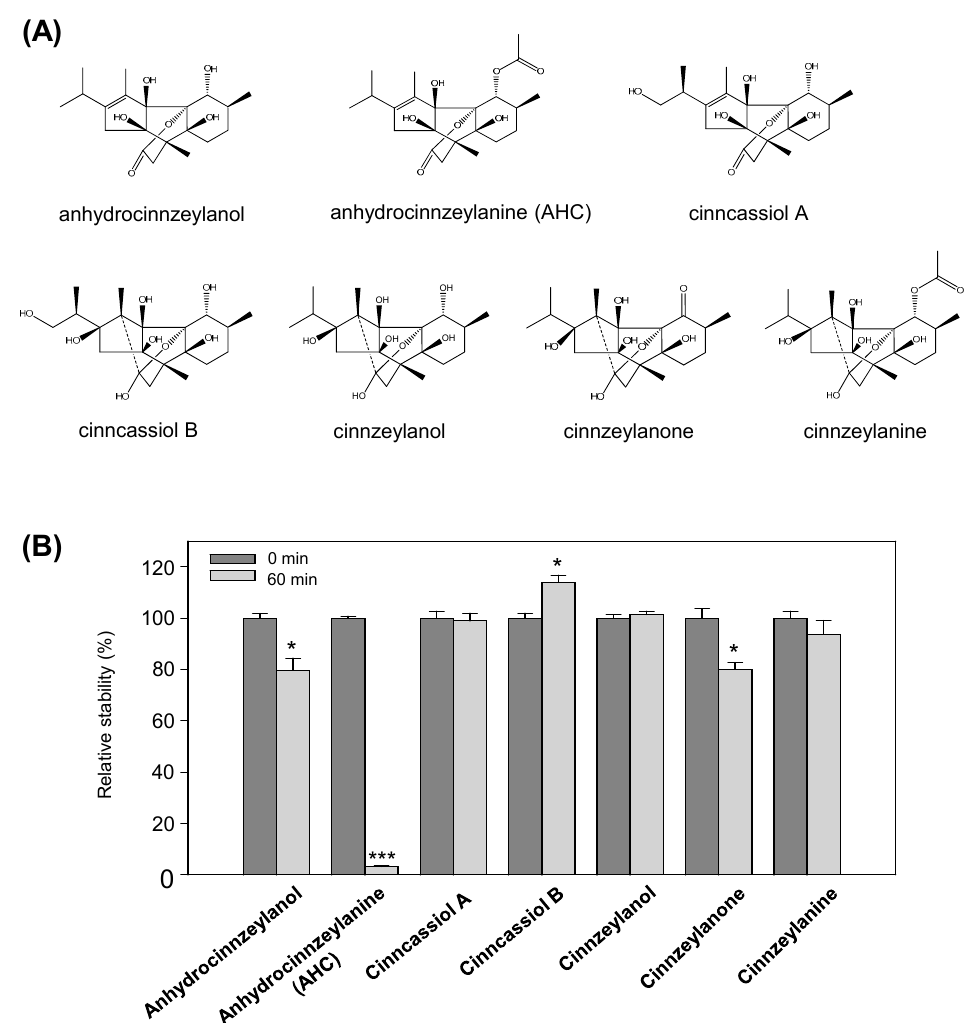
Figure 1. Determination of the metabolic stability of the seven diterpenoids. ( A ) Chemical structures of anhydrocinnzeylanol, cinncassiol A, anhydrocinnzeylanine (AHC), cinncassiol B, cinnzeylanol, cinnzeylanone, and cinnzeylanine. ( B ) Metabolic stability of the seven diterpenoids (10 µM) incubated with 0.5 mg/mL human liver microsomes in the presence of a β -NADPH-regenerating system at 37 °C for 0 or 60 min. Bars indicate standard error ( n = 3). * p < 0.05 and *** p < 0.001.